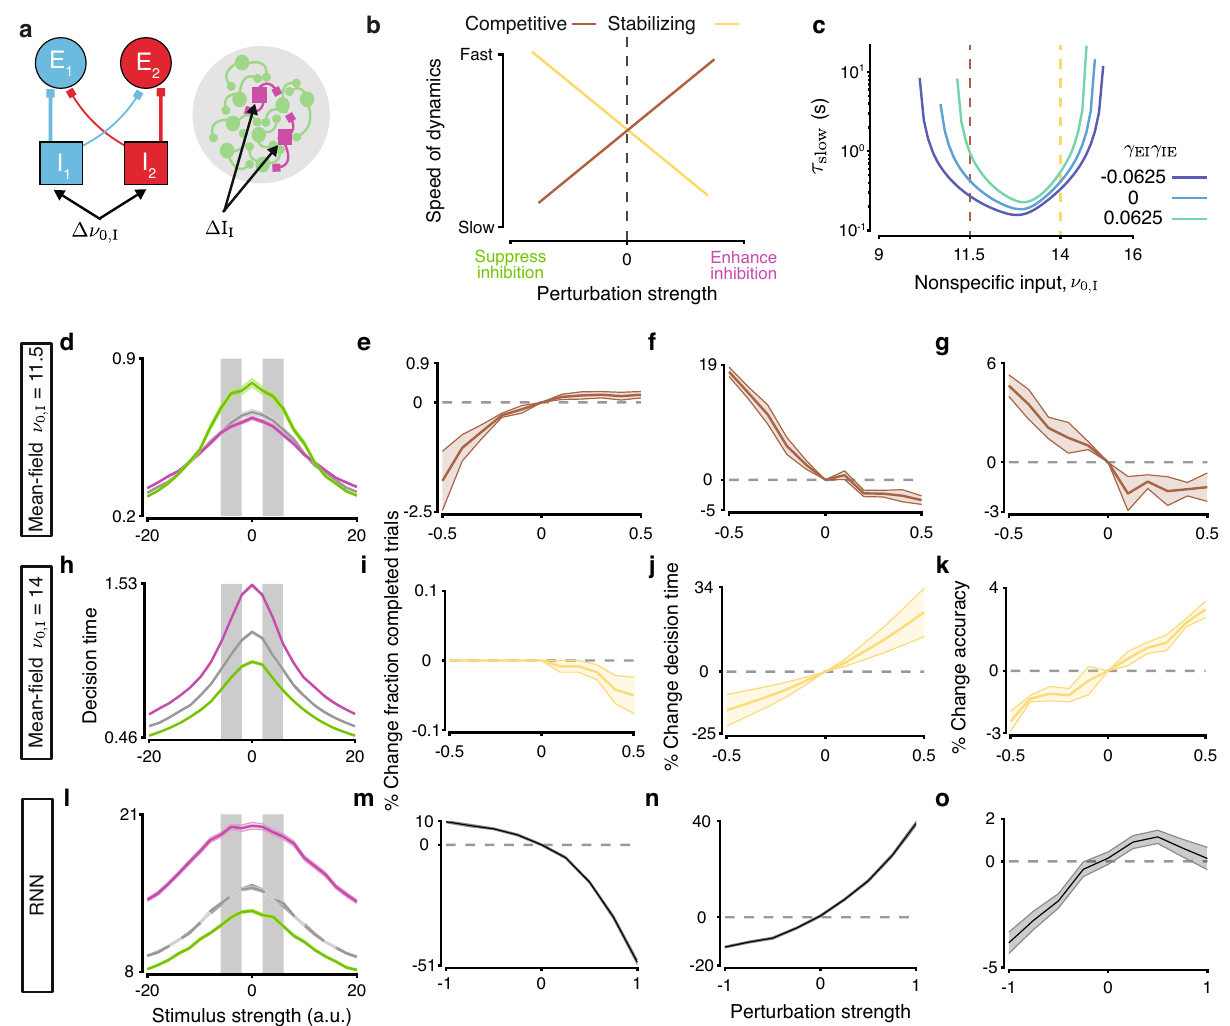
d – g Around alowbaseline ( ν 0,I =11.5,brownline in c ),enhancinginhibition speeds up decision times (magenta line in d ; f ), increases the rate of trial completion ( e ), and decreases accuracy( g ),whereassuppressing inhibition produces the opposite effects, e.g., slows down decision times (green line in d ; f ). Results are shown for nonspeci fi c circuits. Gray areas in d indicate stimulus strengths used to calculated the values in e – g . Error bars indicate±s.e.m. across 2000 trials. h – k Same as d – g for the high inhibition regime ( ν 0,I =14, yellow line in c ). Perturbations of inhibitory activity produce the reversed effects. Error bars indicate±s.e.m. across 2000trials. l – o Sameas h – k forperturbationsofinhibitoryneuronsinRNNs.RNN ’ s response to perturbations mirrors the effects in the mean- fi eld model in the sta- bilizingregime(c.f. h – k ).EnhancinginhibitioninRNNsslowsdowndecisiontimes, decreases the rate of trial completion, and increases accuracy. Error bars indi- cate±s.e.m. across 75